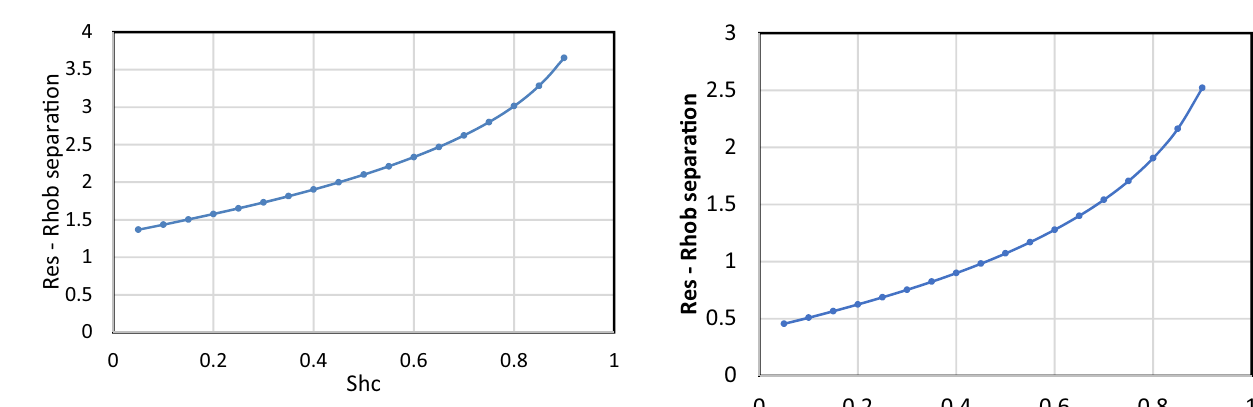
V m = 2, Φ = 0.3 c = 0,